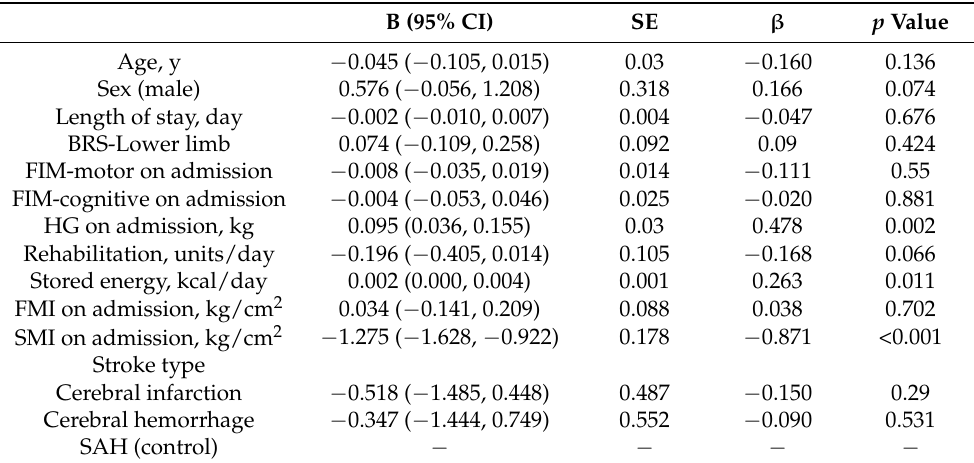
Table 4. Multivariate regression analysis for SMM gain during